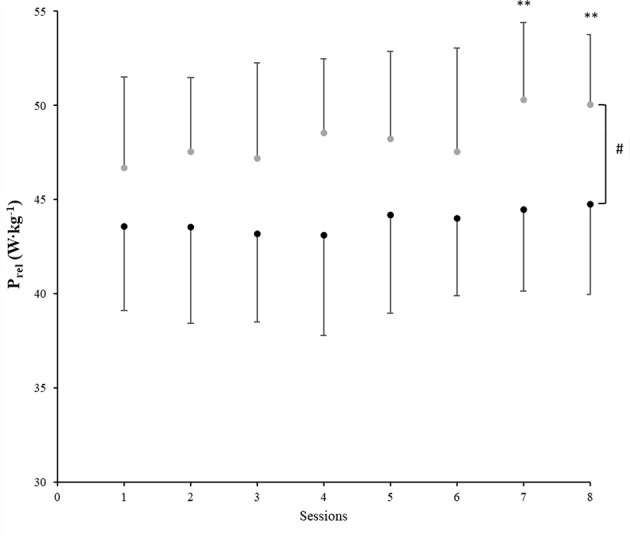
Session averaged relative peak power (Prel) ± SD during the 5 × 6 repetitions-set exercises for both groups (IH: , N: ), across the 4-weeks RT program. Significant differences were **among sessions (compared with the first session, P < 0.001) and #between groups (P < 0.05).